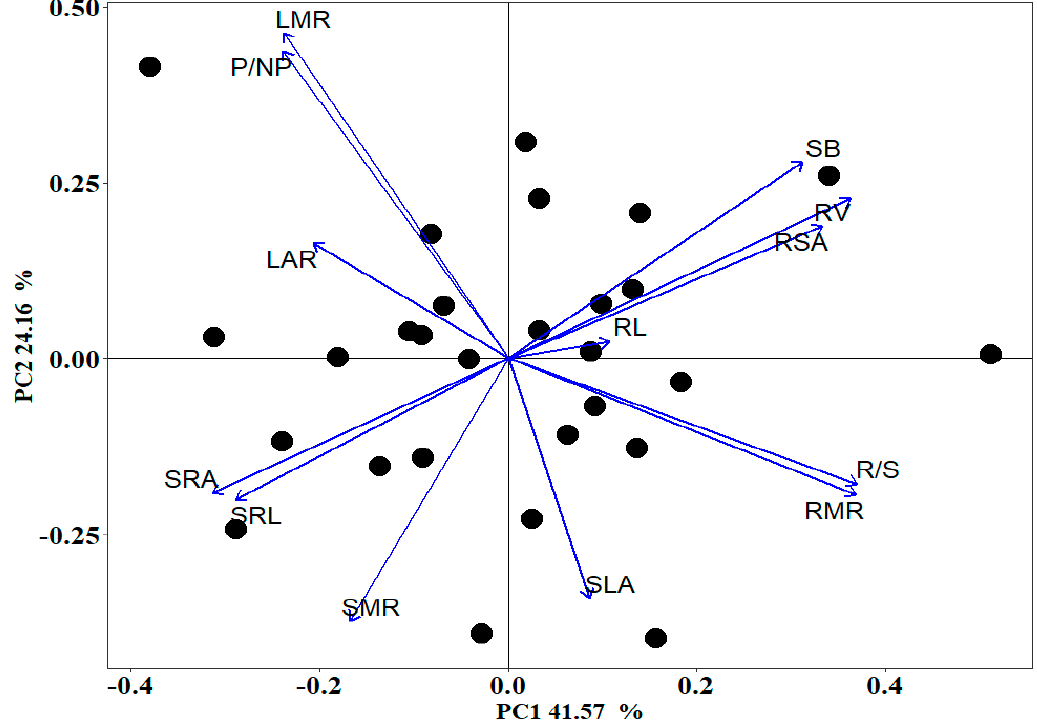
Figure 9. Principal component analysis of Quercus acutissima seedling traits. SB: seedling biomass; RMR: root mass ratio; SMR: stem mass ratio; LMR: leaf mass ratio; R/S: root/shoot ratio; P/NP: photosynthetic tissues/non-photosynthetic tissues; SLA: specific leaf area; LAR: leaf area ratio; RL: root length; RSA: root surface area; RV: root volume; SRL: specific root length; SRA: specific root surface area.